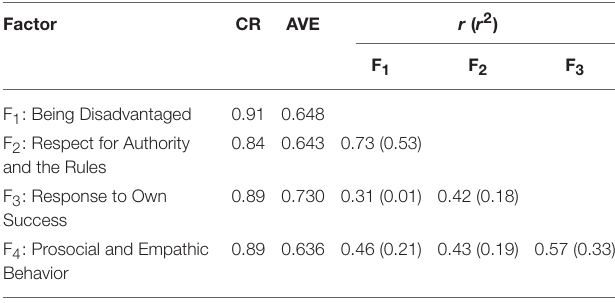
TABLE 3 | Composite reliability indices, variance extracted indices, and correlations between the factors of the rejected students. Factor